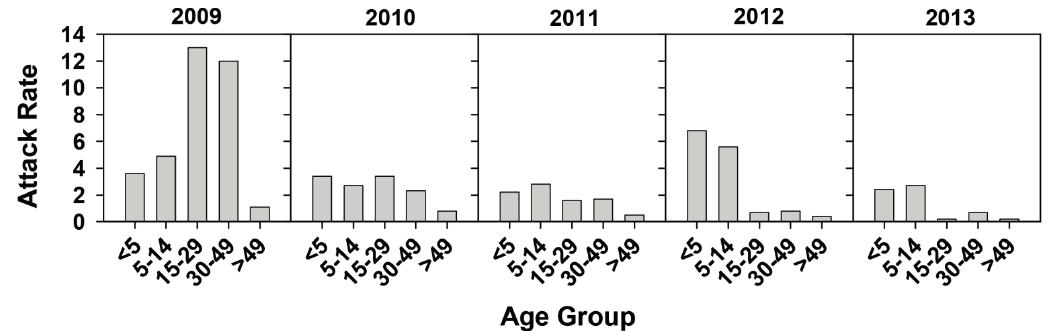
Figure 2. Hepatitis A attack rates for different age groups during the 2009–2013 period in Catalonia, Spain, in the context of a universal vaccination campaign for preadolescents at the age of 12 years. Data is distributed in natural years. Attack rates are defined as the number of cases per 100,000 inhabitants of each age